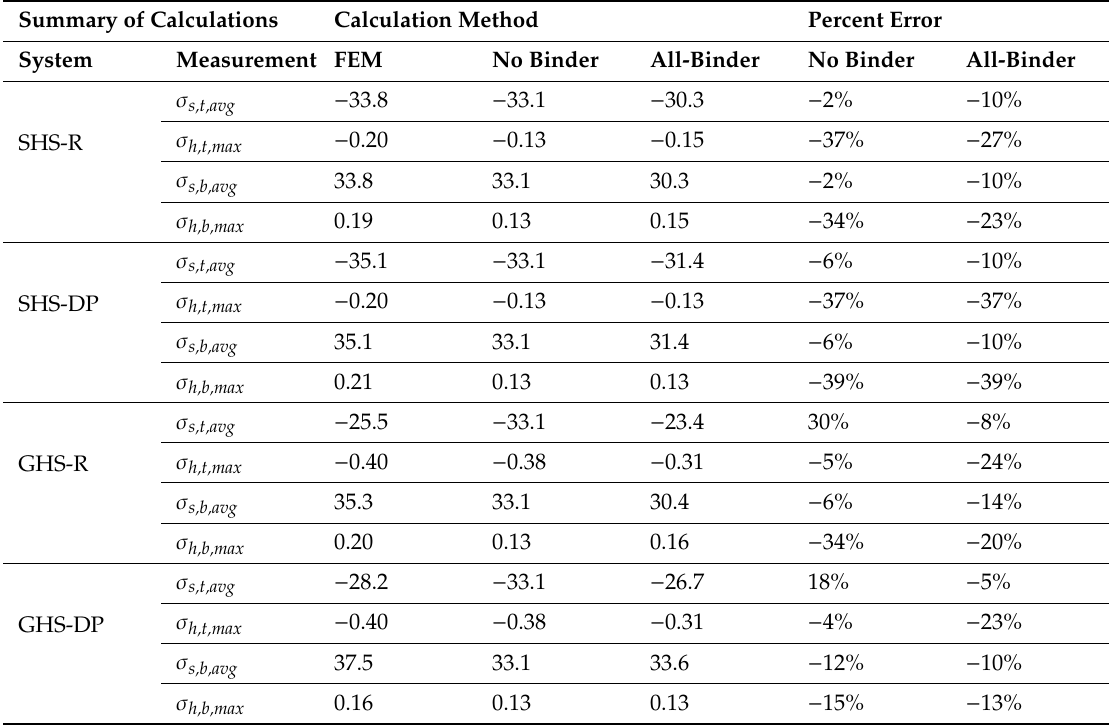
Table 4. The FEM stresses are compared against all-binder and no binder assumptions. The percent error for both against the FEM results is also